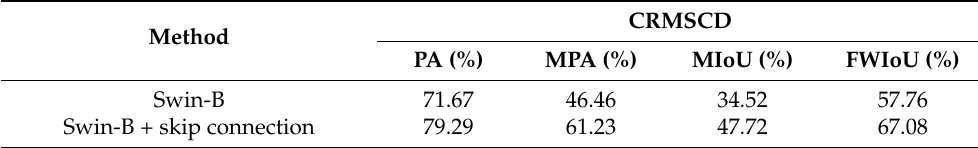
Table 12. Experiment of skip connection on transformer-based